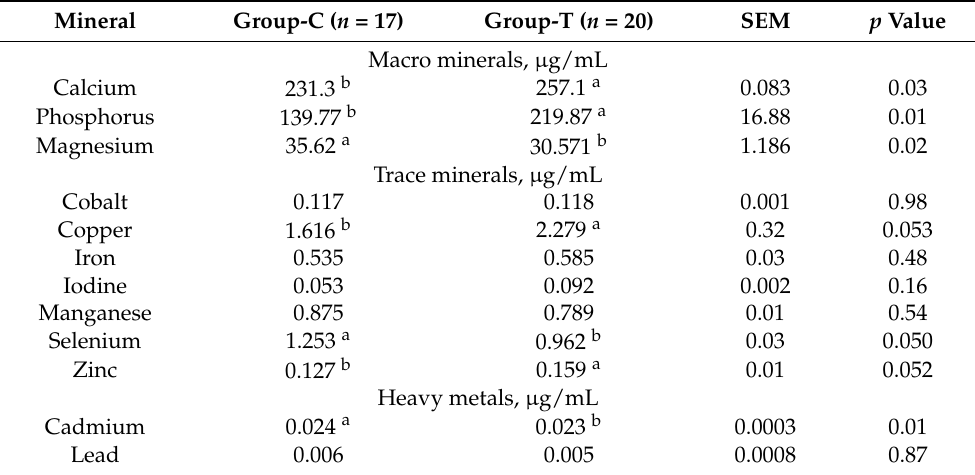
Table 4. Element concentrations (ug/mL) in the blood serum of female camels raised in a semi- intensive system during winter.